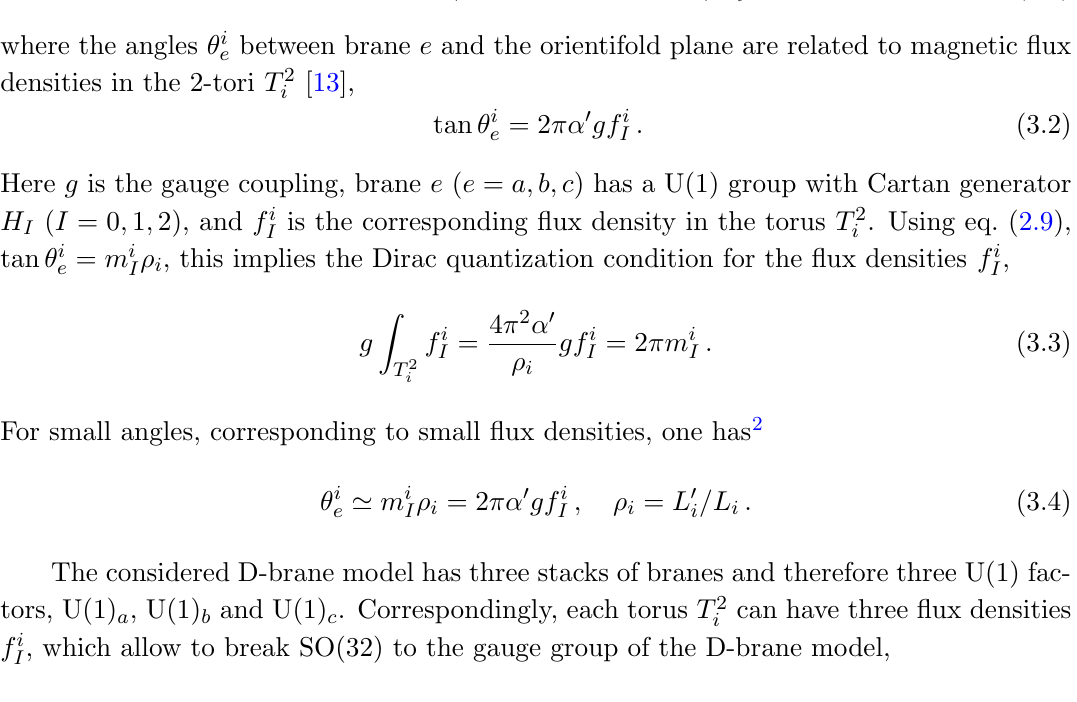
(cid:18) i =(cid:25) < 0 : j j